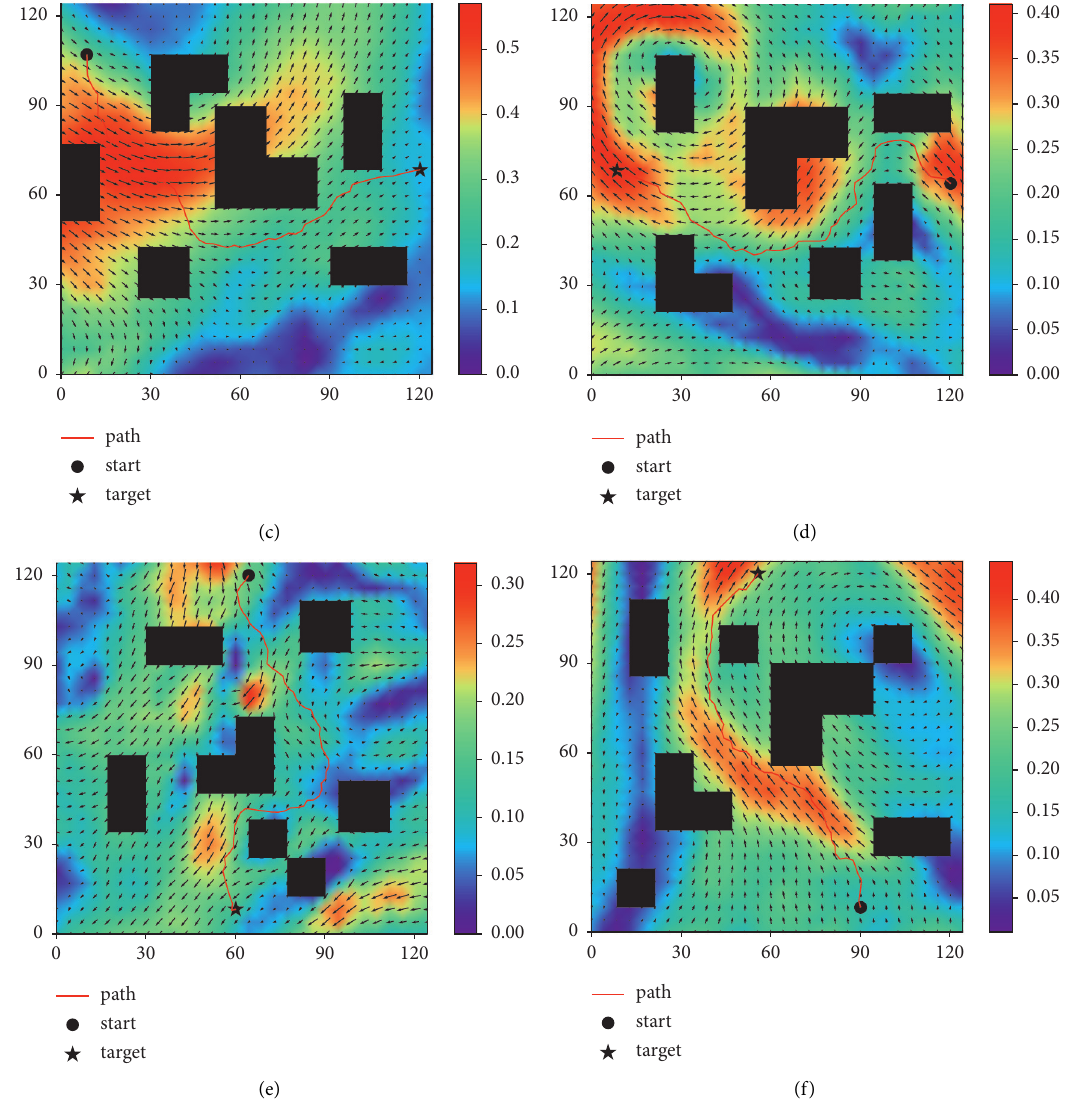
Figure 12: Images of experiments on 128 × 128 ocean maps